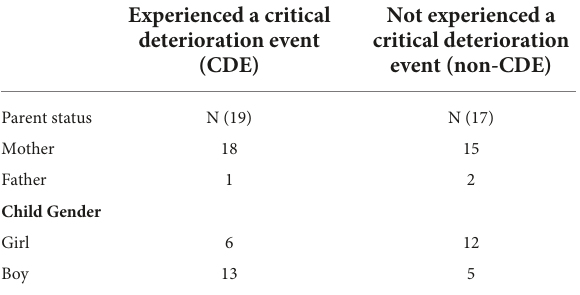
TABLE 2 Parent and child demographics from parent interview